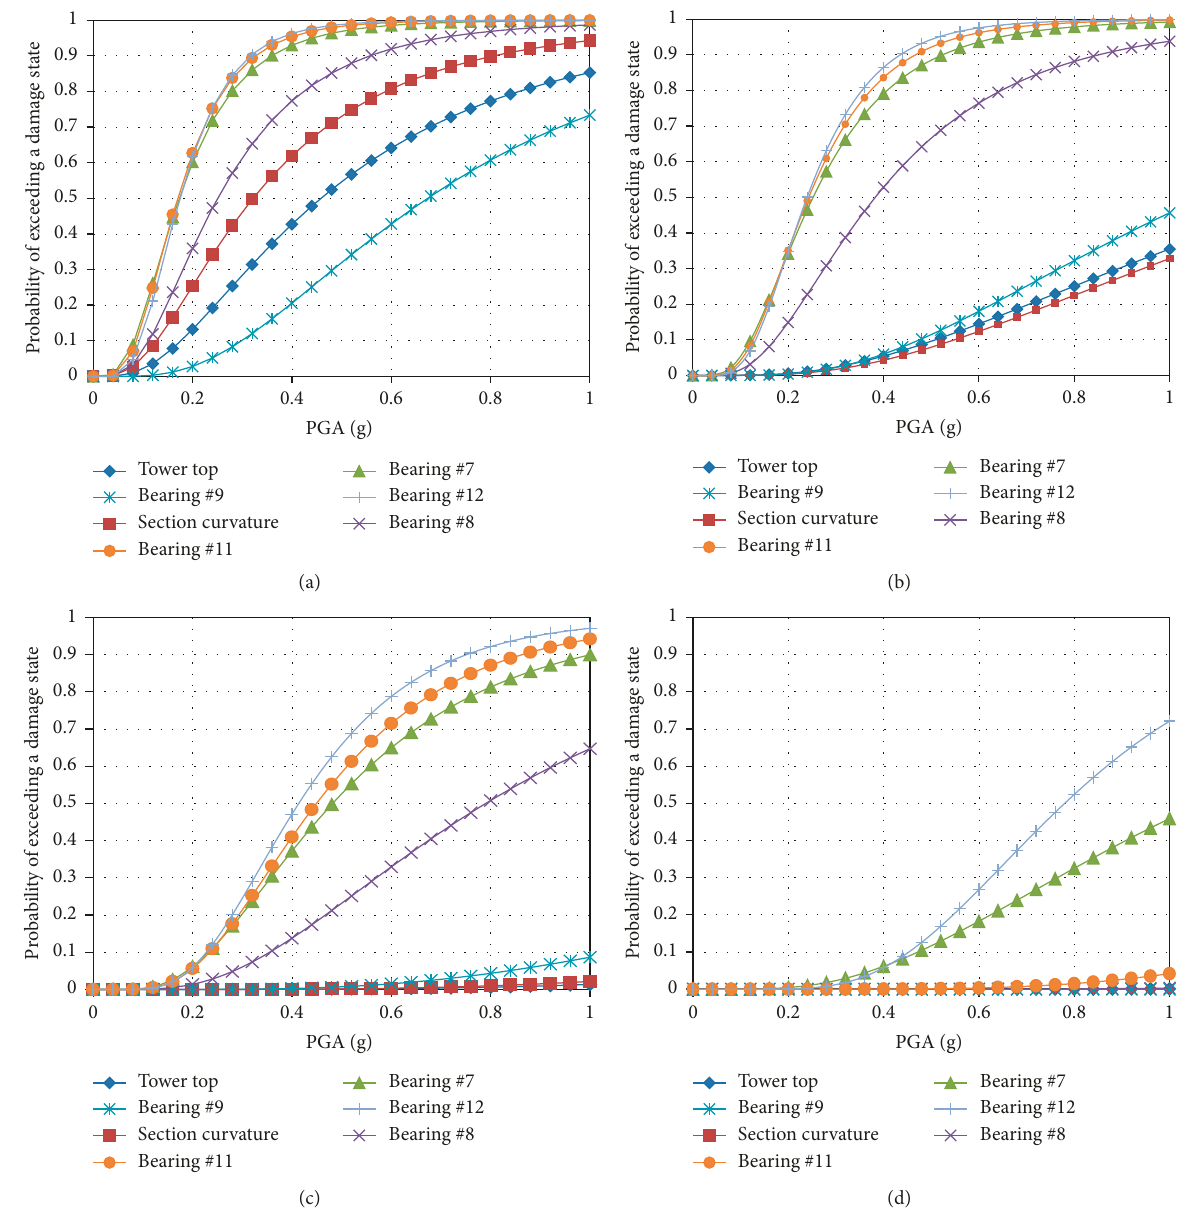
Figure 17: Transversal fragility curves of components. (a) Slight damage. (b) Moderate damage. (c) Extensive damage. (d) Complete